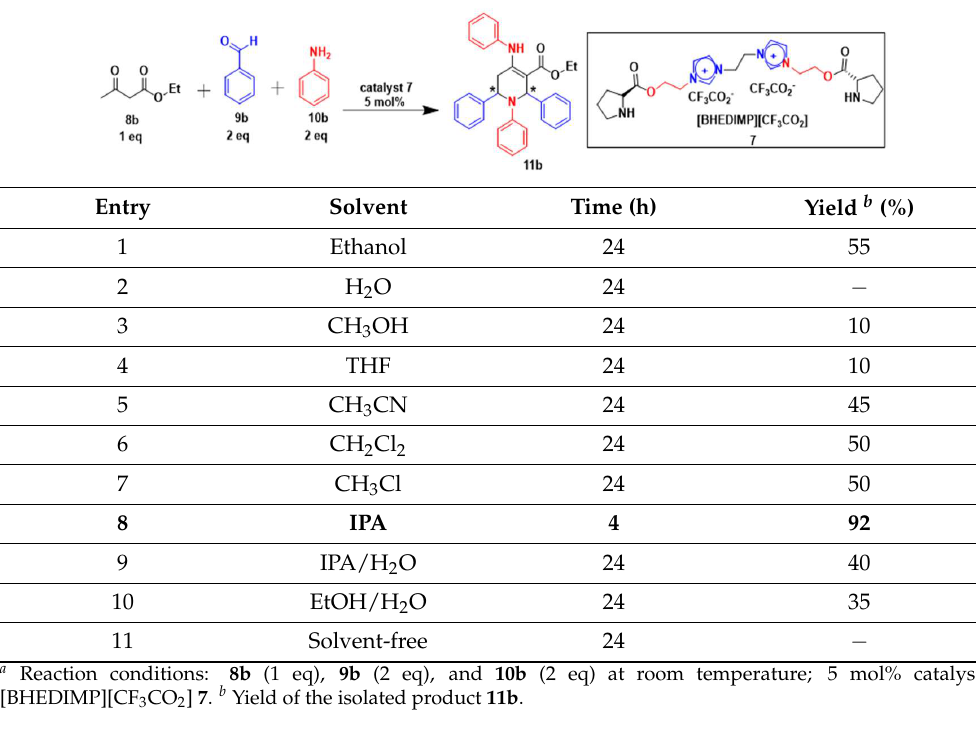
Table 1. Solvent screening for the synthesis of 11b a .